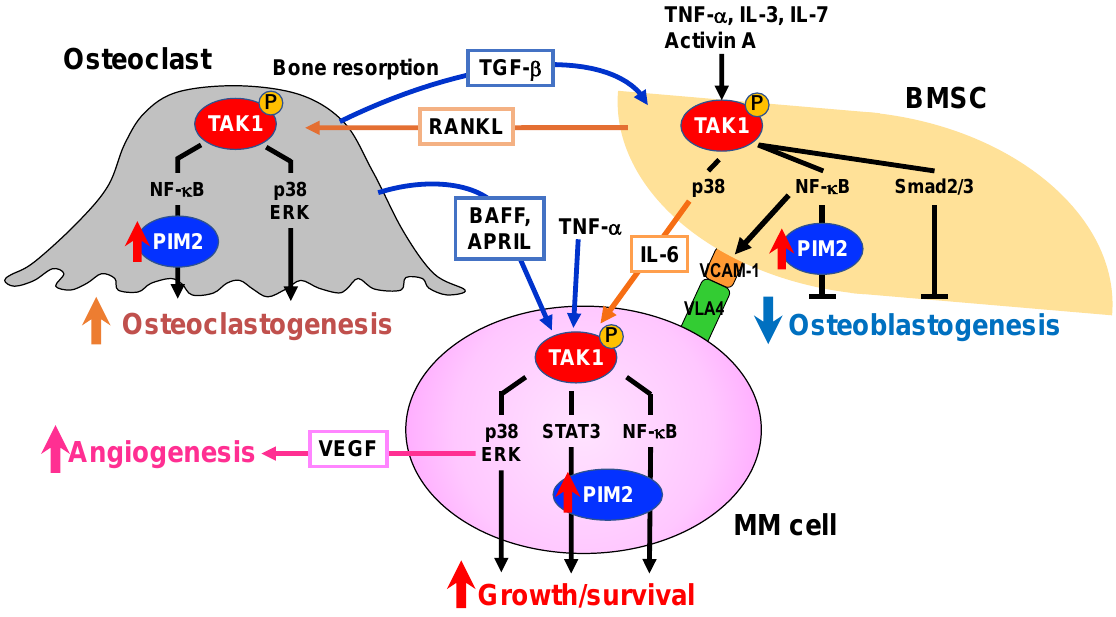
Figure 3. TAK1 as a pivotal therapeutic target in MM. Bone marrow microenvironment is skewed in MM, which confers tumor aggressiveness and progressive bone destruction, posing highly unmet issues. TAK1 mediates a wide range of intracellular signaling pathways. TAK1 is constitutively overexpressed and phosphorylated in MM cells and further upregulated through interaction with bone marrow stromal cells (BMSCs) and osteoclasts. TAK1 mediates major growth and survival signaling pathways in MM cells. TAK1 activation also enhances VEGF production via ERK. TAK1 phosphorylation is also induced to upregulate the expression of vascular cell adhesion molecule-1 (VCAM-1) in BMSCs in the presence of MM cells, which facilitates MM cell-BMSCs adhesion while inducing IL-6 and receptor activator of NF- κ B ligand (RANKL) expression by BMSCs. RANKL activates TAK1 in osteoclast precursors to induce osteoclastogenesis. Furthermore, TGF- β released from bone matrices through enhanced bone resorption, activin A produced by environmental cells, and MM cell- derived factors, including IL-3, IL-7, and TNF α , trigger TAK1 phosphorylation in BMSCs to block their osteoblastogenesis. PIM2 is upregulated downstream of TAK1. Therefore, TAK1 activation is vital for MM cell growth and survival and bone destruction. A novel anti-MM treatment with bone modifying actions by TAK1 inhibition can be